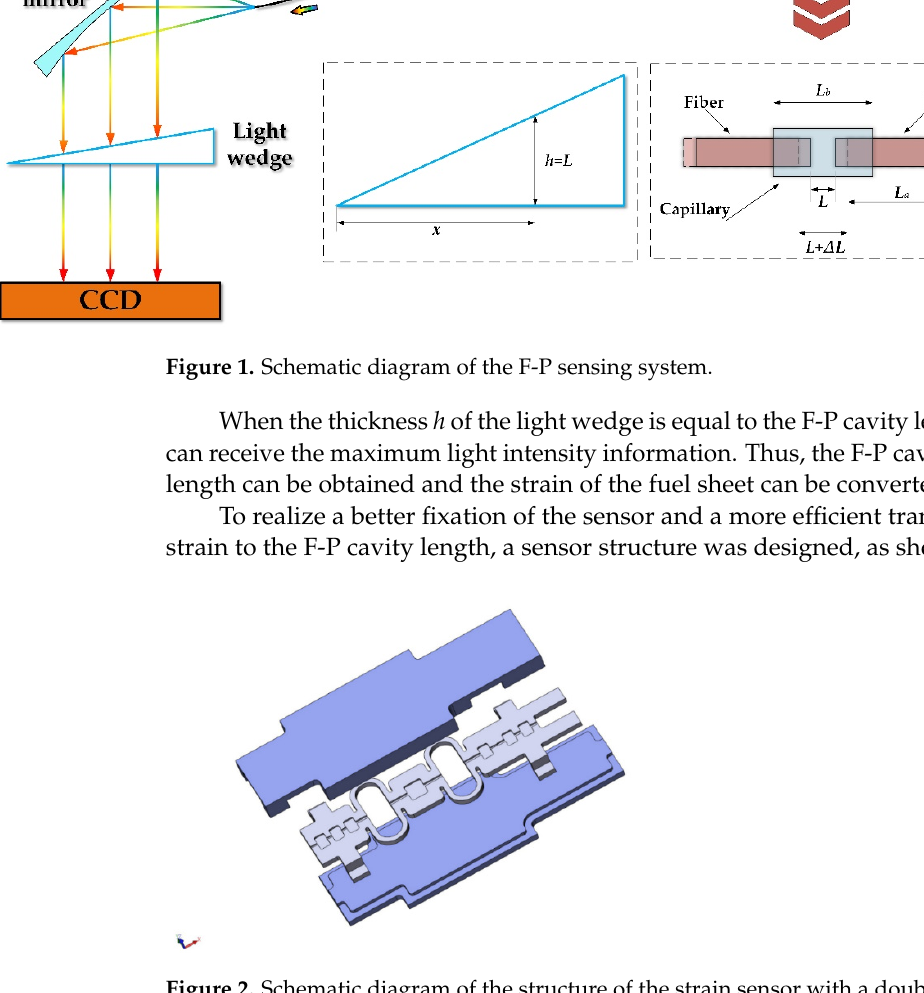
Figure 2. Schematic diagram of the structure of the strain sensor with a double spring ring.